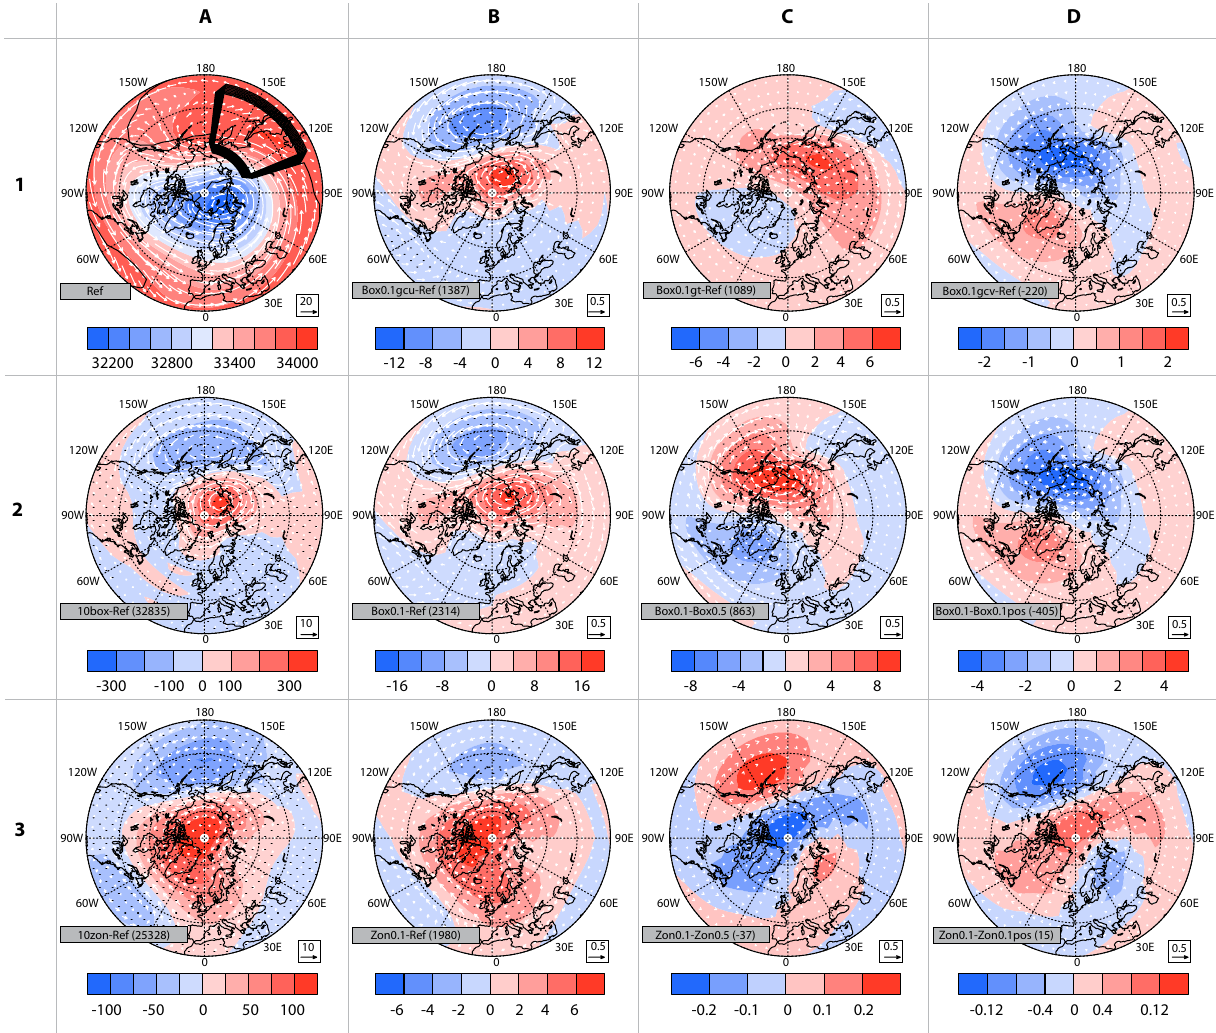
Figure 5. Mean geopotential and horizontal wind vectors at the 13th model level (6.25hPa) for the reference simulation and differences for the sensitivity simulations with different GWD set-up. From top left (index 1a) to bottom right (index 3-D): (a1) reference simulation overlaid with an illustration of the box area, (b1) reference–Box0.1gcu, (c1) reference–Box0.1gt, (d1) reference–Box0.1gcv, (a2) reference–10box, (b2) reference-Box0.1, (c2) Box0.1–Box0.5, (d2) Box0.1–Box0.1pos, (a3) reference–10zon, (b3) reference–Zon0.1, (c3) Zon0.1–Zon0.5 and (d3) Zon0.1–Zon0.1pos. Colours indicate geopotential height (gpm). Note the different scaling of the respective plots. Arrows refer to horizontal wind [ms − 1 ] with unity arrows given below the individual plots. The statistical significance of the mean geopotential differences was computed by a t test and regions with p values < 0 . 05 are stippled. The sum of geopotential difference across the plotted area is given in the legend to each